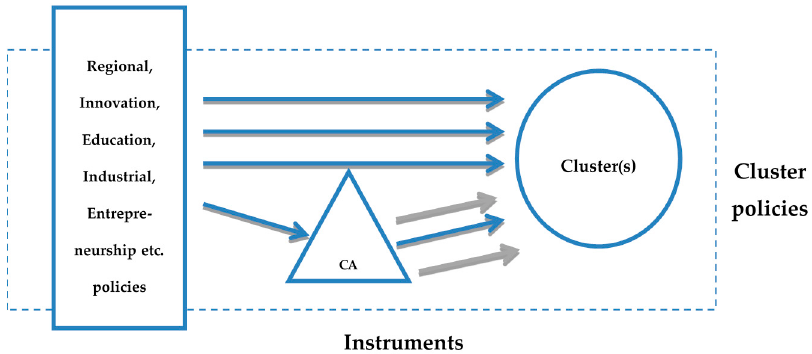
Figure 1. Positioning cluster association within cluster policies. Source: Konstantynova and Wilson [25].